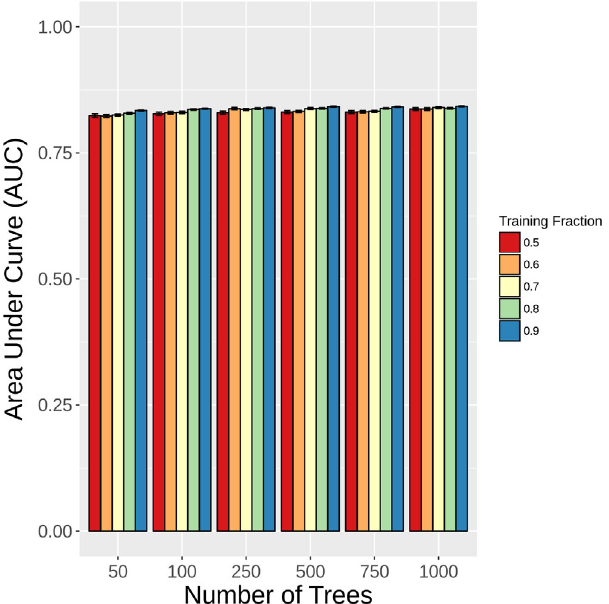
6. Average area under the curve of the model for various training fractions and number of trees in the forest. Error bars correspond to a standard